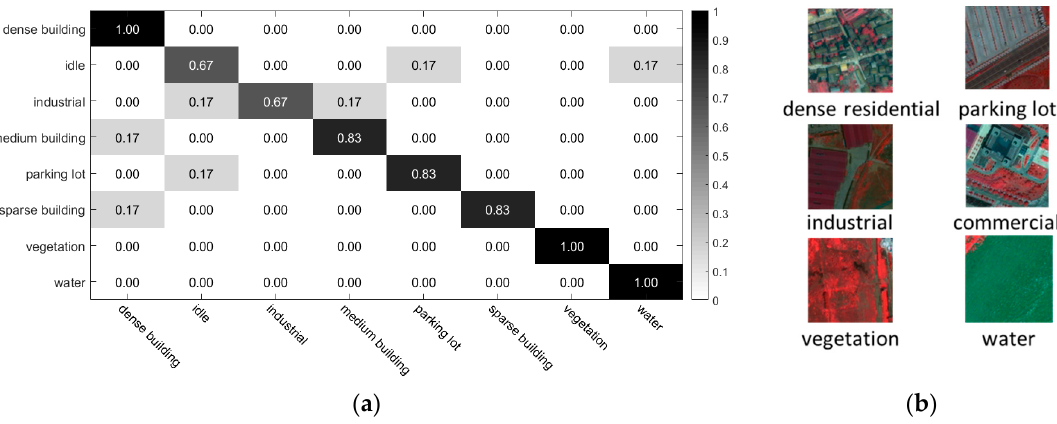
Figure 15. ( a ) The confusion matrix for the Wuhan IKONOS dataset based on MOSCRF; and ( b ) some of the classification results that MOSCRF can recognize while frequency vector